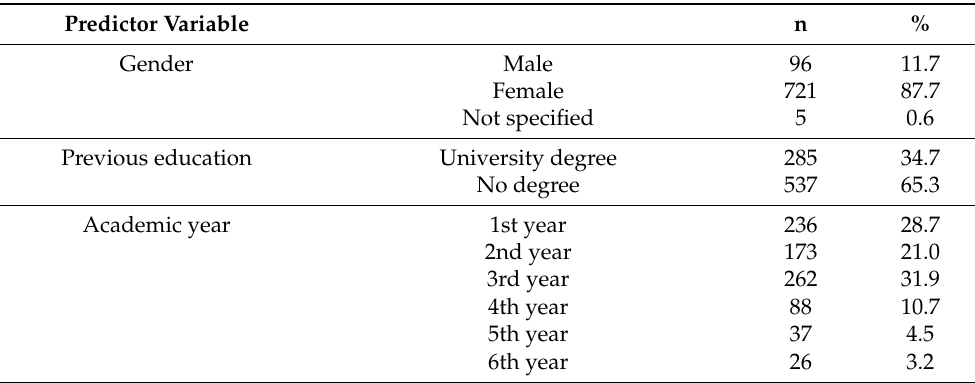
Table 2. Participants’ demographic